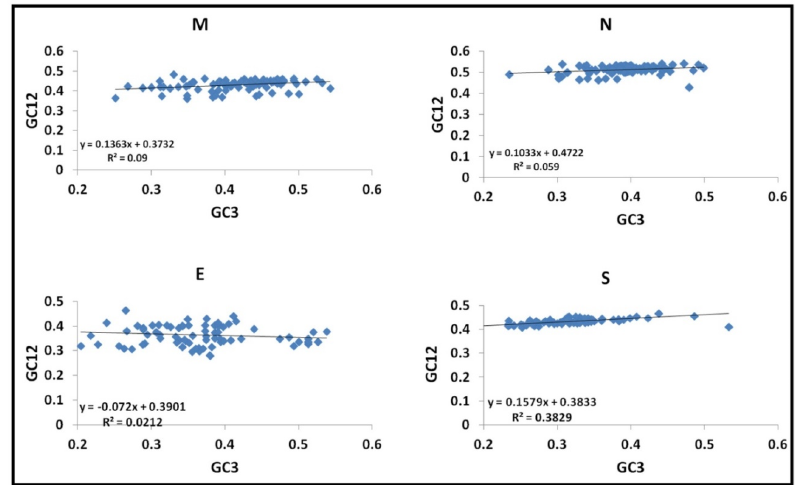
Figure 4. Neutrality plot for the different structural genes of the Coronaviridae family: The nucleotide frequency of GC at the first two codon positions vs. GC content at the third codon position is plotted for different genes. The GC12 vs. GC3 values for viruses are depicted as a blue point. The slope of the linear regression through these points denotes the mutational pressure for different genes analyzed. The slopes of the regression line calculated for M, N, S and E genes are found to be 0.136, 0.103, −0.072 and 0.158, respectively. Thus , the slope observed for the genes suggests the role of mainly natural selection being present at the codon positions.The slope of the E gene was followed by the N gene and indicated a mutational pressure of 7.2% and 10.3%, respectively. The relative neutrality (natural selection)was calculated to be 92.8% and 89.7%, indicating that natural selection plays a